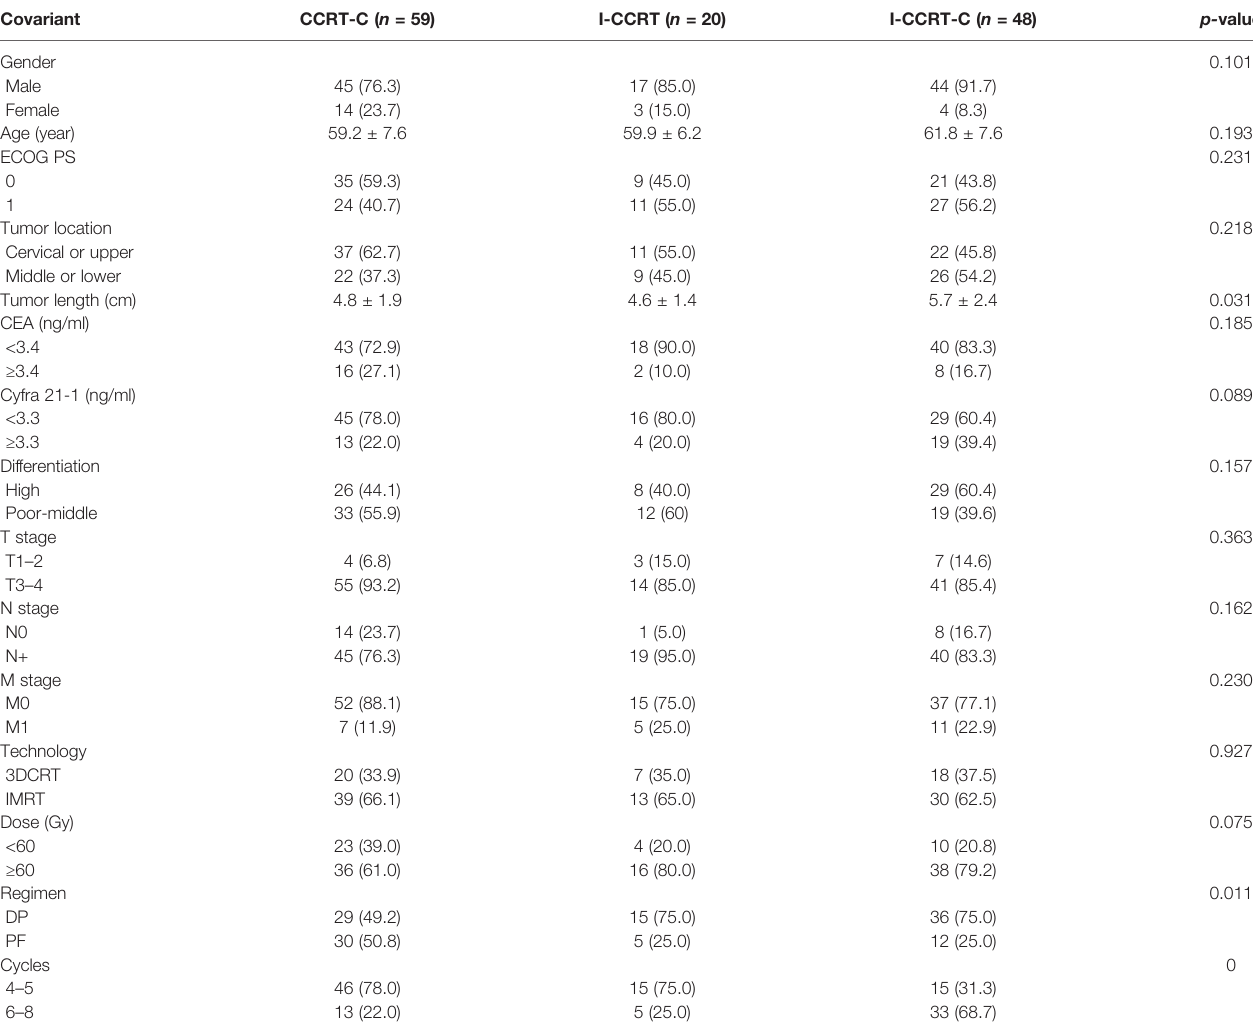
TABLE 1 | Characteristics of patients [ n (%)].